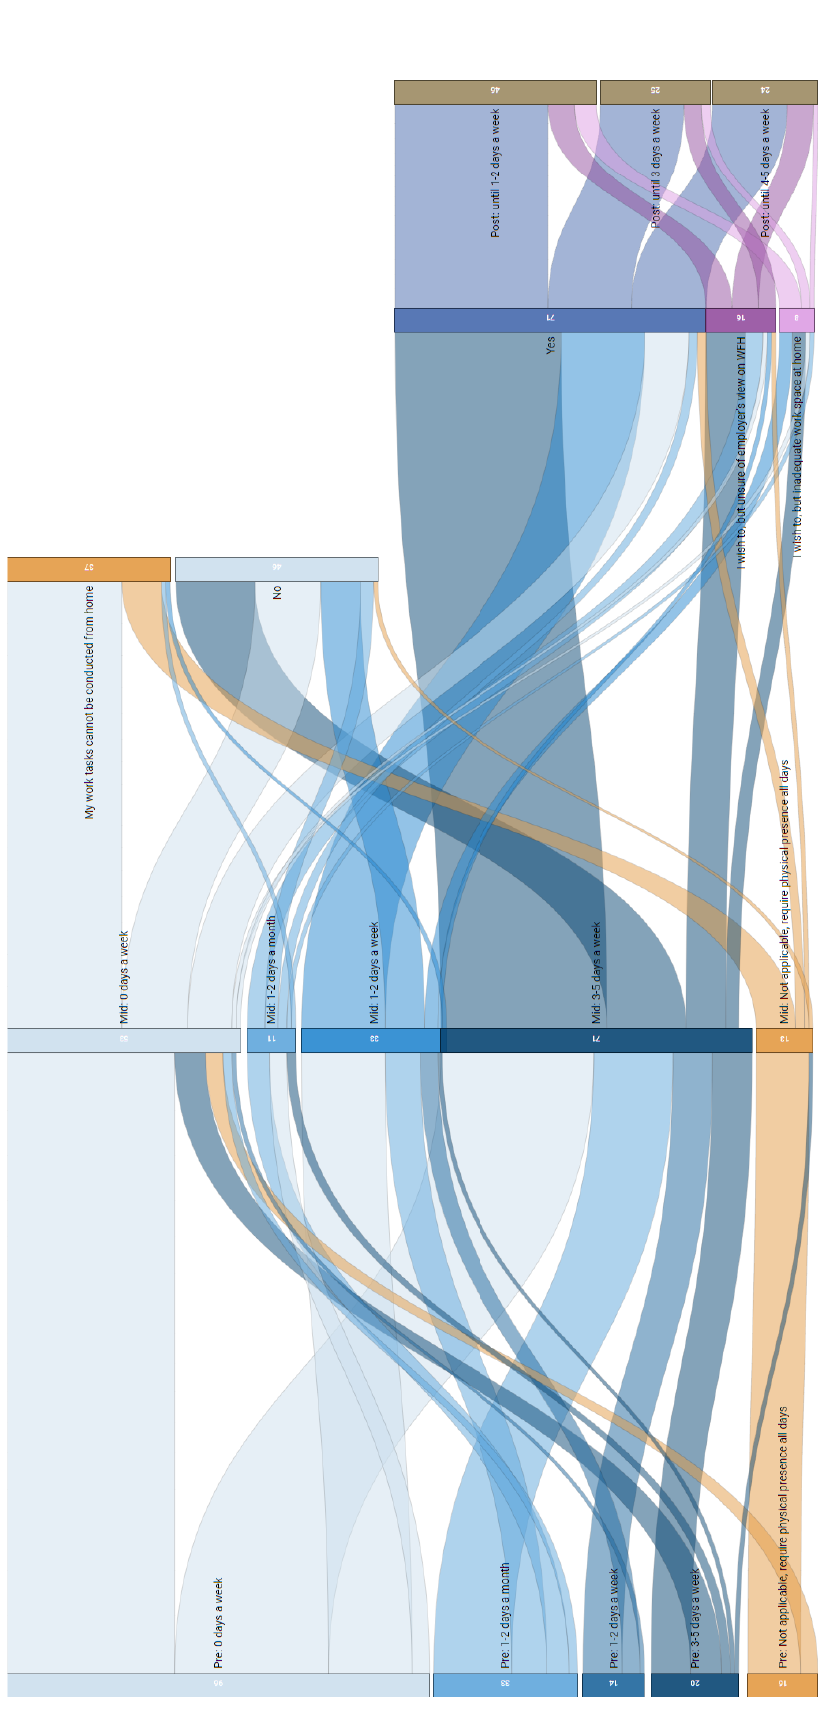
Figure 8. Share of respondents having telecommuting before, during and wanting to after the pandemic.